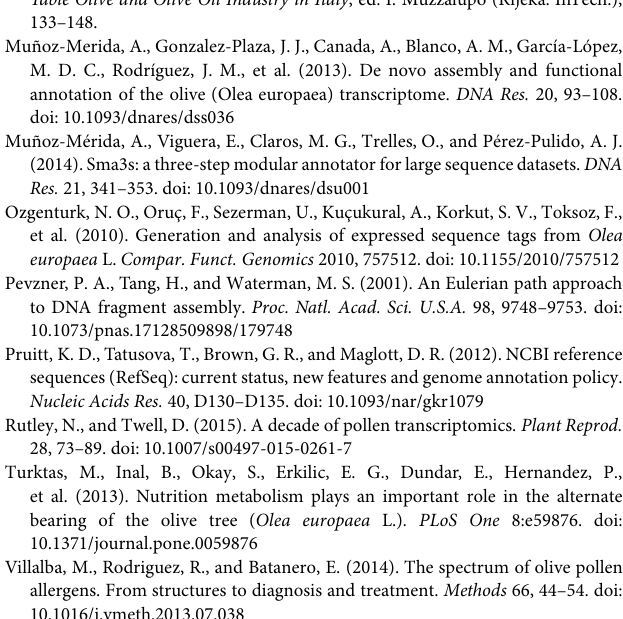
Table Olive and Olive Oil Industry in Italy , ed. I. Muzzalupo (Rijeka: InTech.),